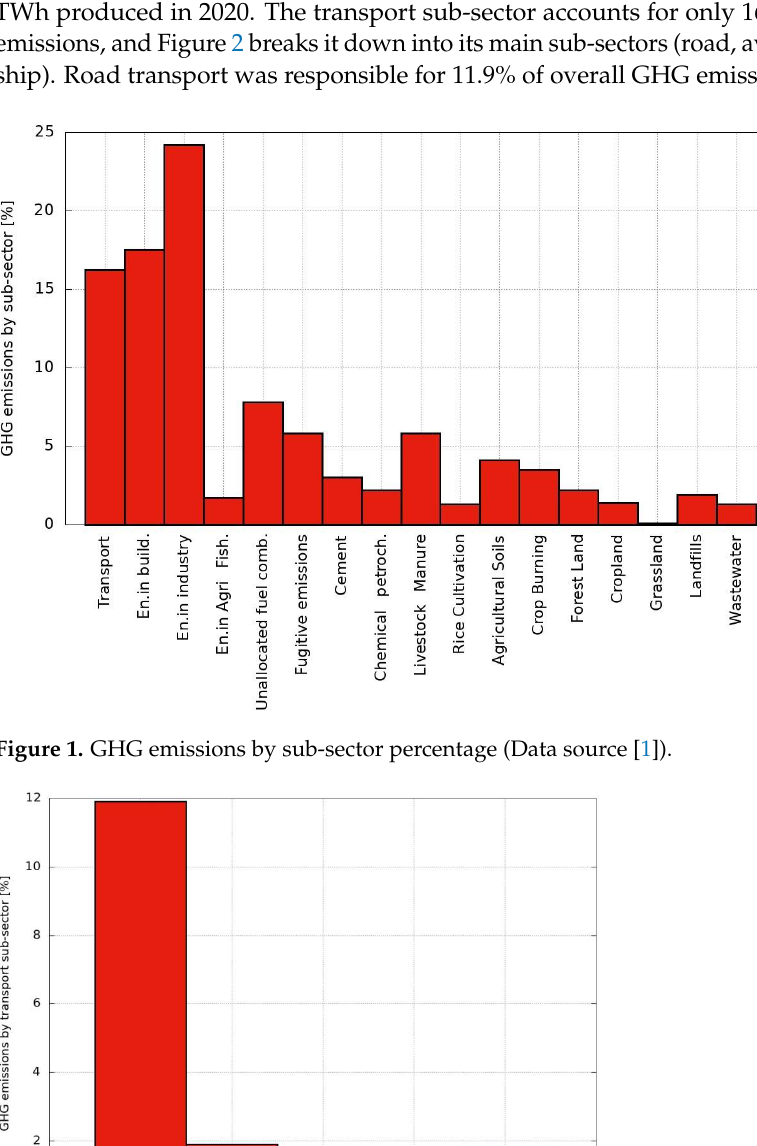
Figure 2. GHG emissions by transport sub-sector percentage (Data source [1]).